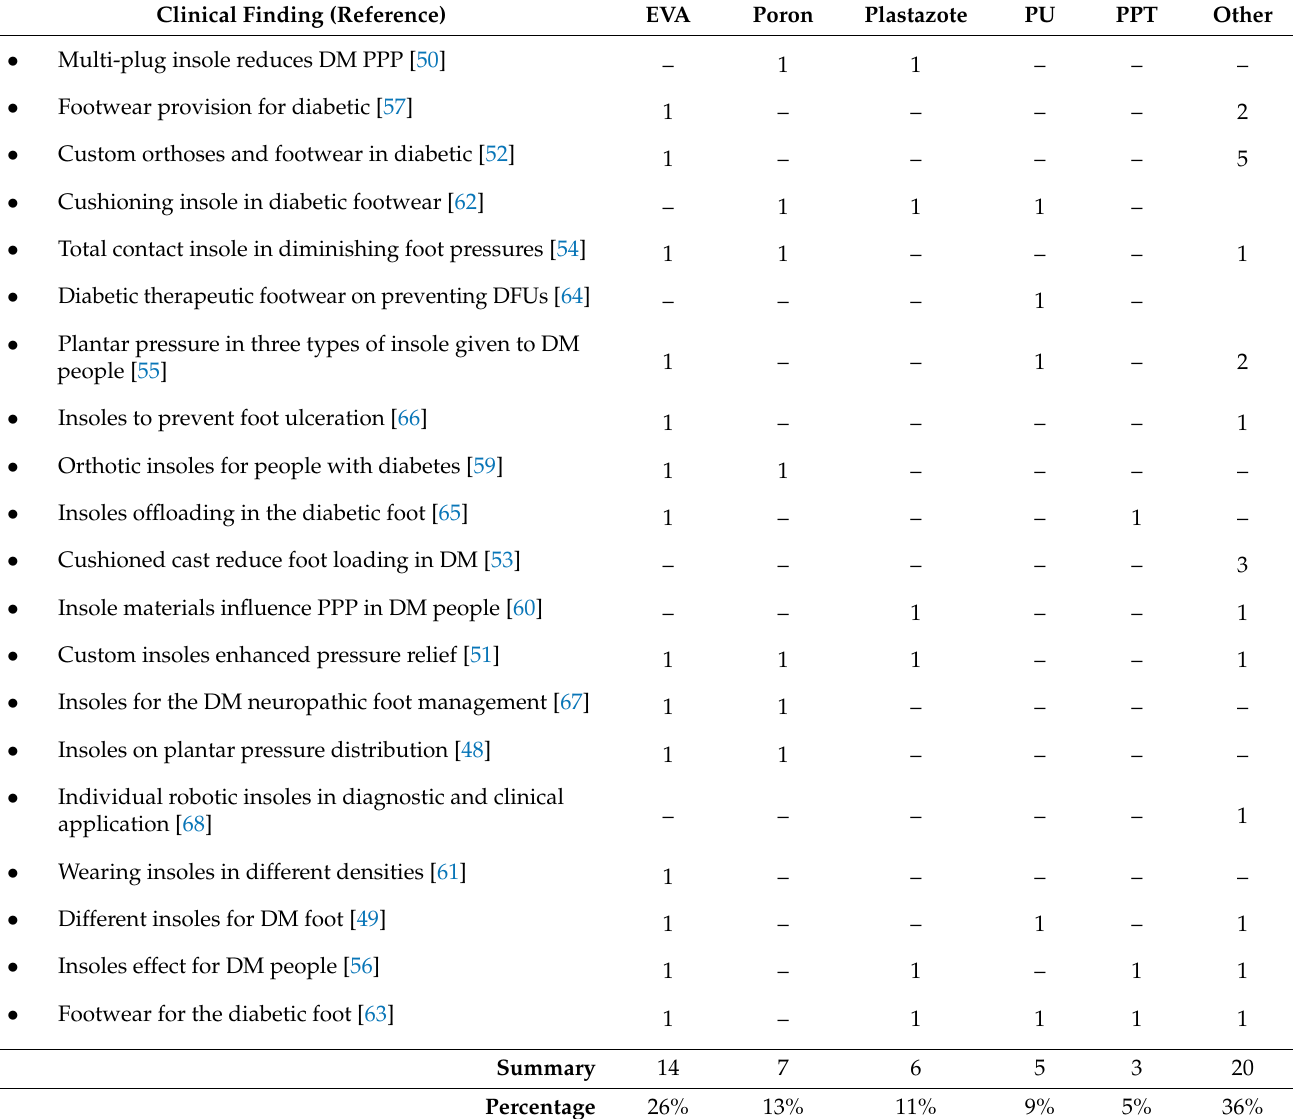
Table 2. The published paper discussed selected insole materials on the forefoot region. Clinical Finding (Reference)